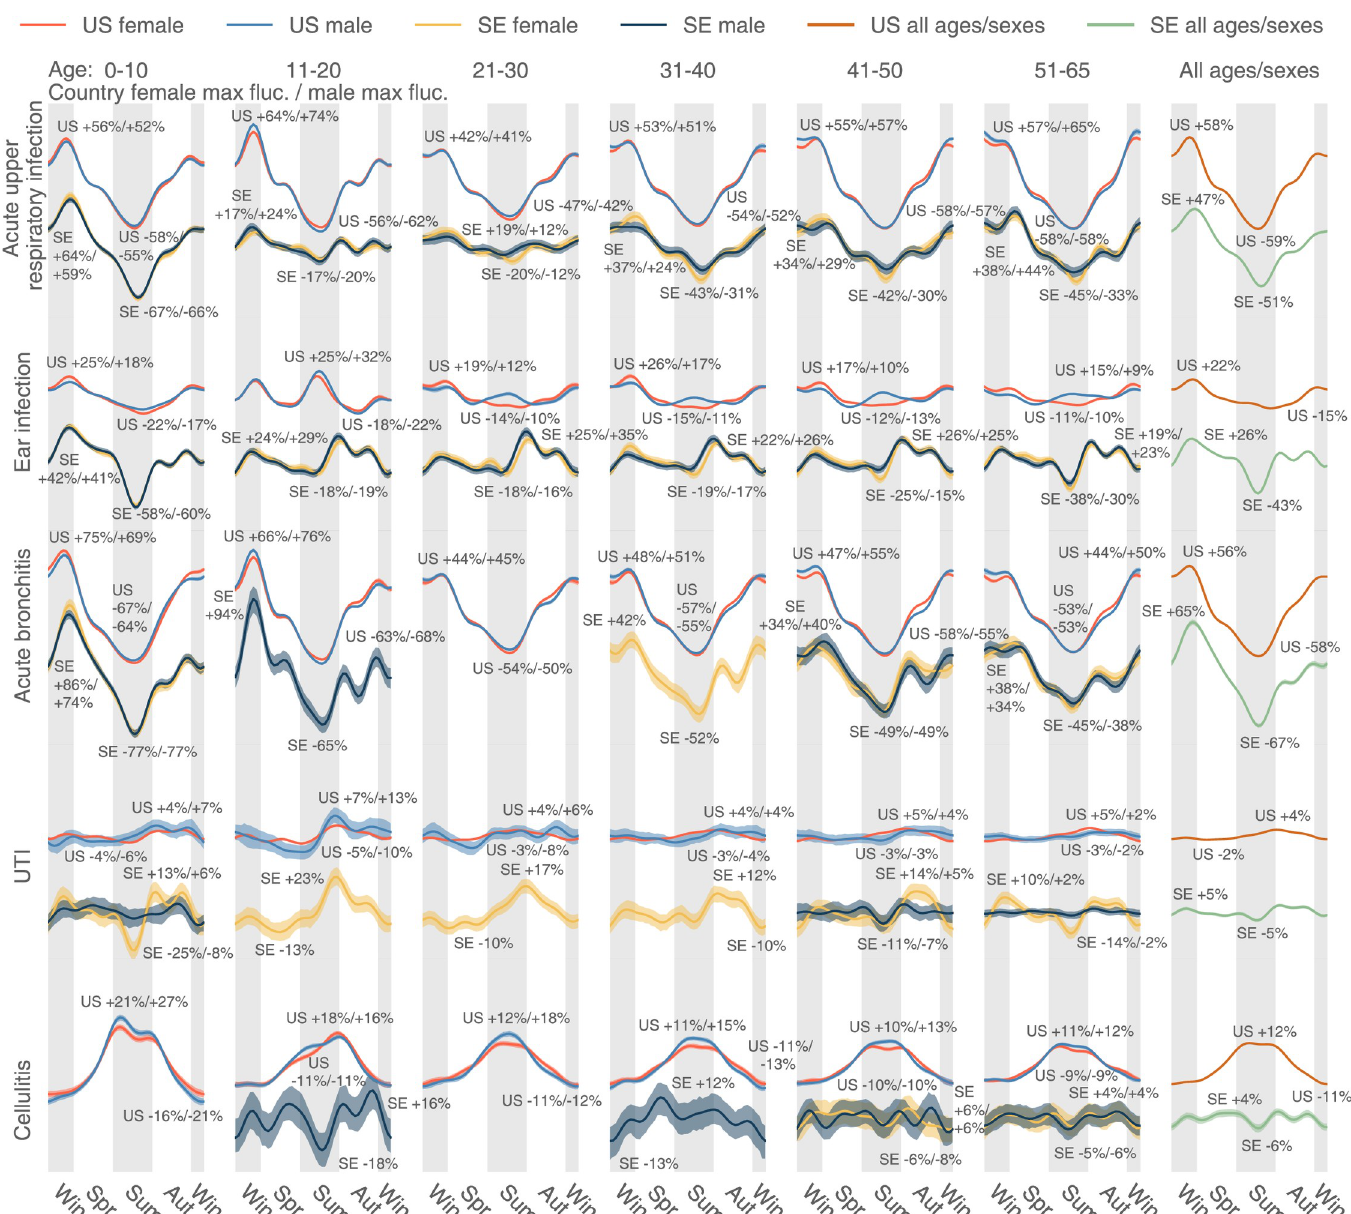
Fig 4. The uncorrected seasonality plots of the 5 most diagnosed infectious diseases in the US: Acute upper respiratory infection, ear infection, acute bronchitis, UTI, and cellulitis. The results in SE are juxtaposed without scaling. A disease could be extremely rare in some age–sex brackets. The plot only shows those age–sex– specific seasonalities with a time-average DR larger than 1 × 10 − 5 . The data underlying this figure can be found in https://doi.org/10.5061/dryad.vdncjsxv6. DR, diagnosis rate; SE, Sweden; UTI, urinary tract infection.